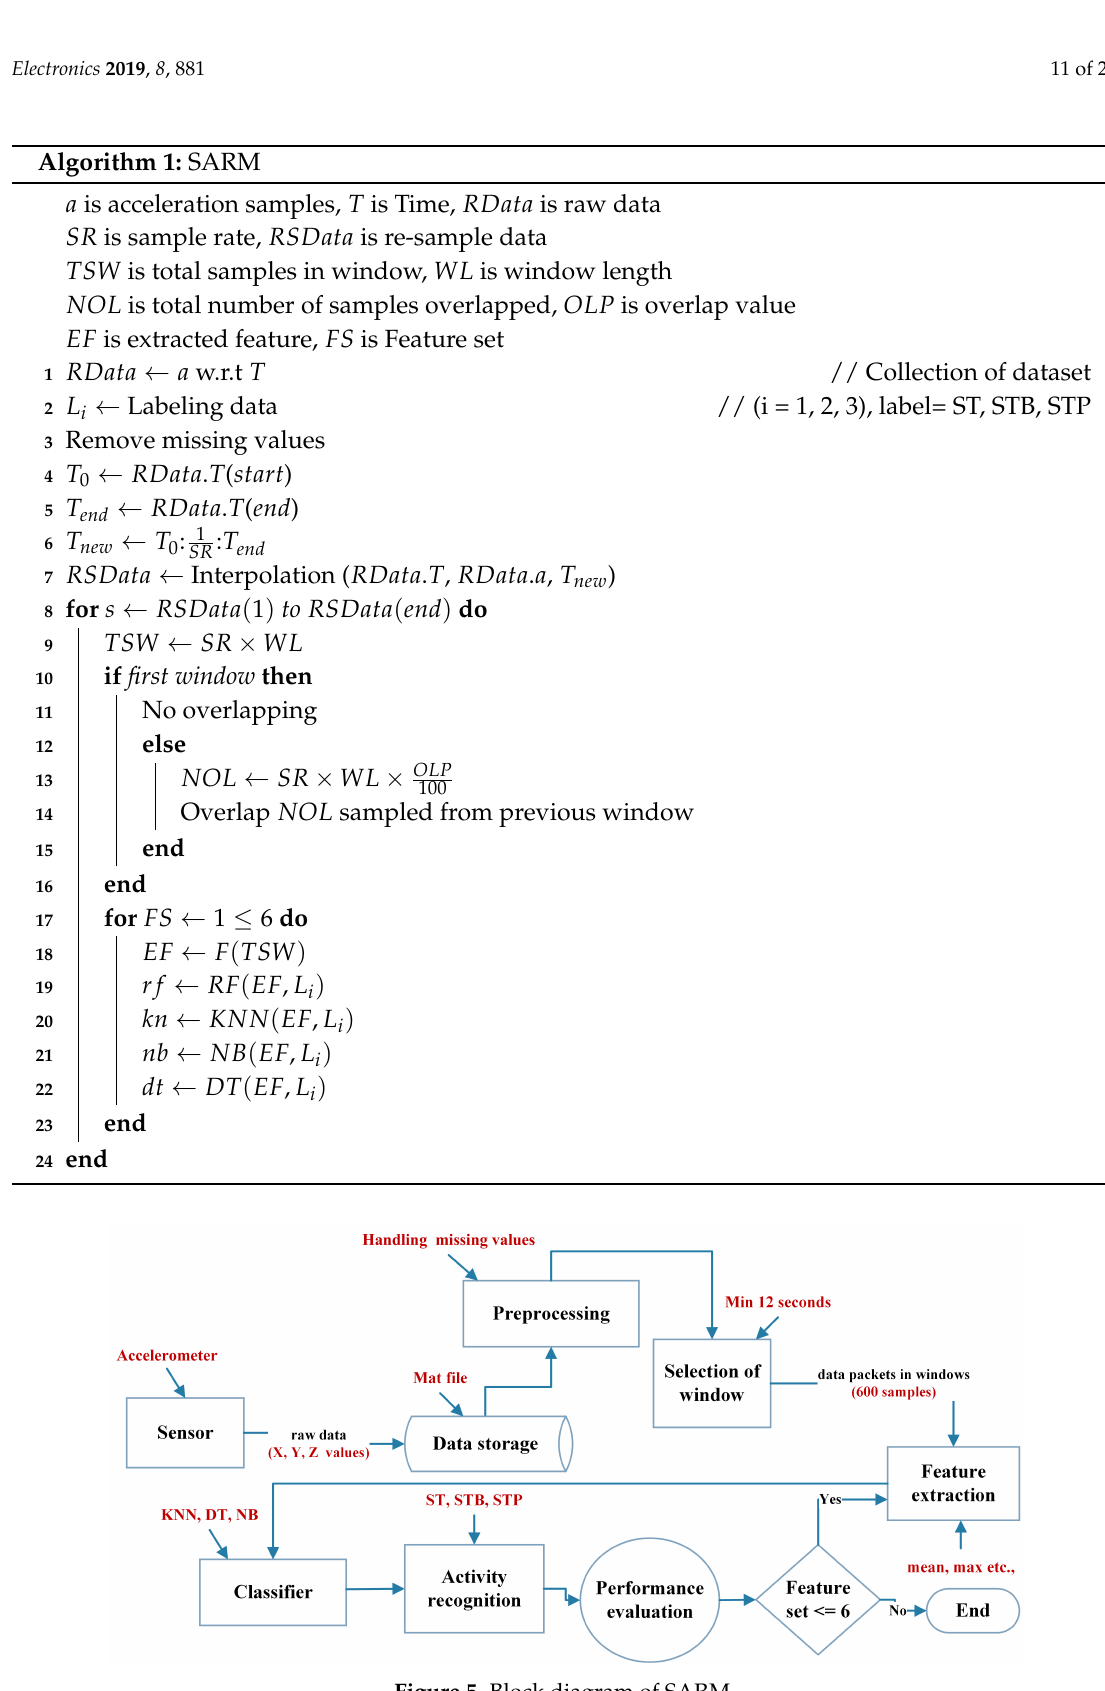
Figure 5. Block diagram of